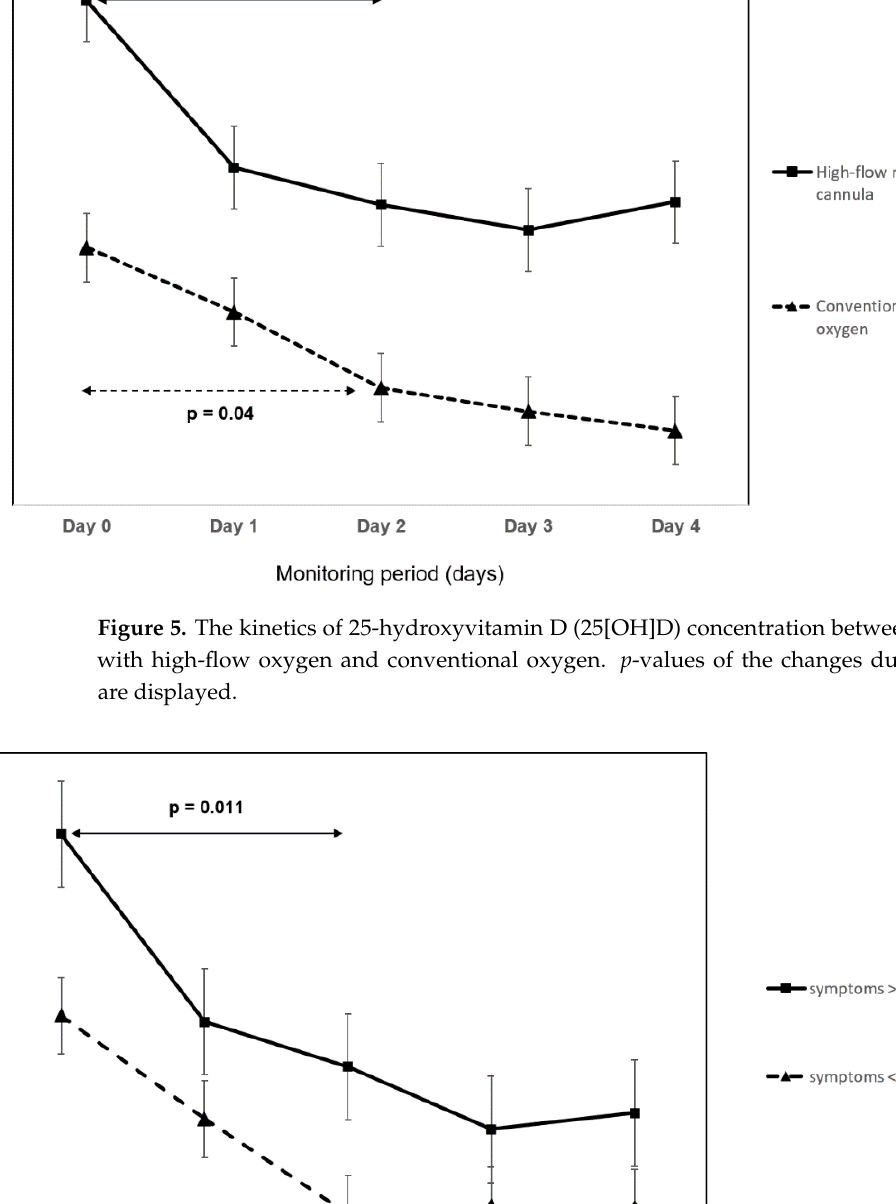
Figure 4. The kinetics of 25-hydroxyvitamin D (25[OH]D) concentration during hospitalization between survivors and non-survivors. p -values of the changes during the first 48 h are displayed.